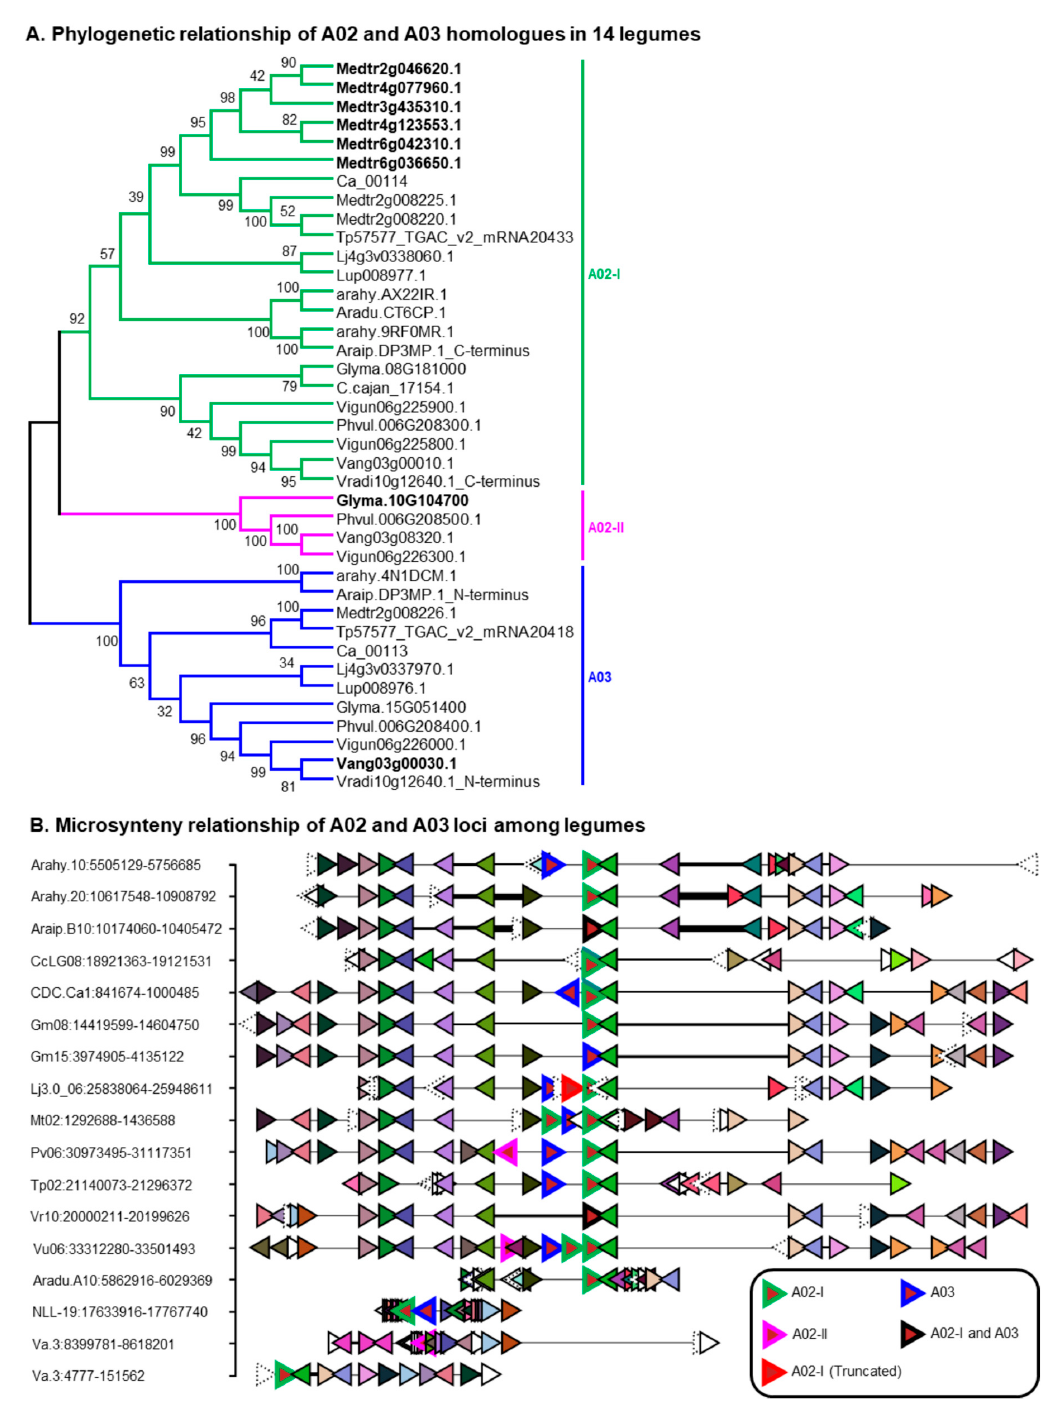
Figure 2. Evolutionary history of putative ortholog loci (POL) A02 and A03 in legumes. ( A ). Phylogenetic relationship of A02 and A03 homologs in 14 legumes. Bolded genes are non-synteny homologs with any of the 14 legumes. The full-length sequences of Araip.DP3MP.1 and Vradi10g12640.1 could be a sequencing error; their N-terminus and C-terminus shared high amino acid percent identity with UGT91H5 (A02) and UGT91H4 (A03) members respectively. See Table S9 for species and gene ID’s information. ( B ). Microsynteny relationship of A02 and A03 loci across legumes. Microsyntenic genome segments are retrieved and centered using Phvul.006G208300 . Orthologous / paralogous gene pairs are indicated through the use of a common color. Uncolored and cracked genes are singletons and orphans respectively in this genomic region. Species and genomic positions are mentioned